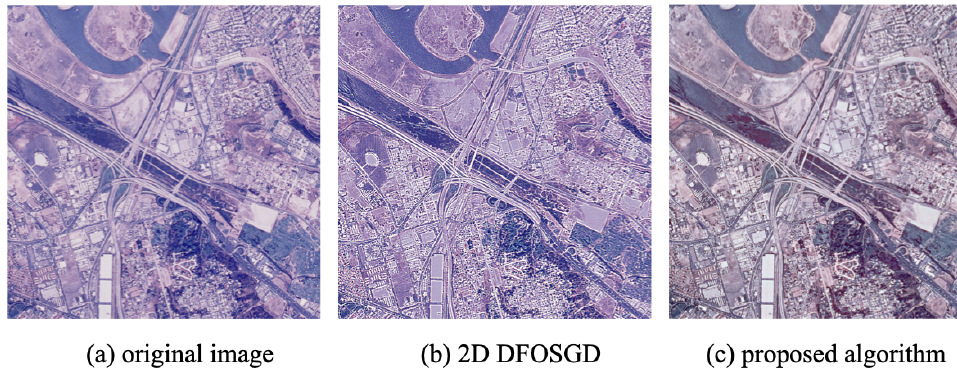
Figure 11. Enhancement results of image “2.1.02”.